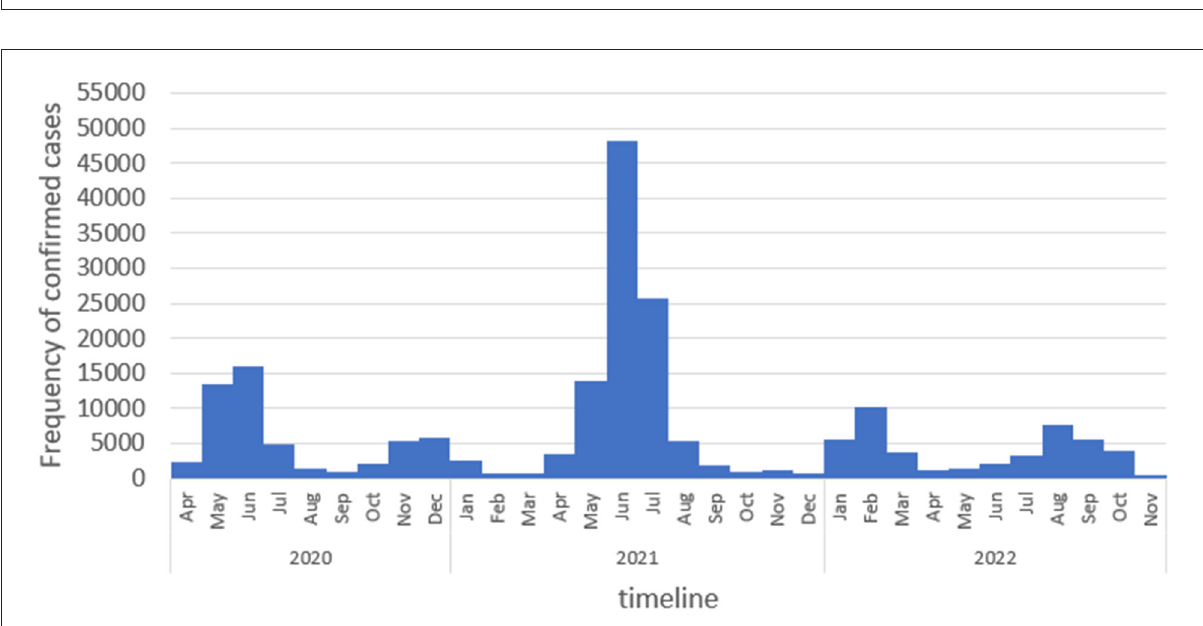
FIGURE2 Frequency distribution of COVID-19 positive cases in Afghanistan. April 2020 to Nov 2022. Source: DHIS2, Afghanistan Ministry of Public Health.